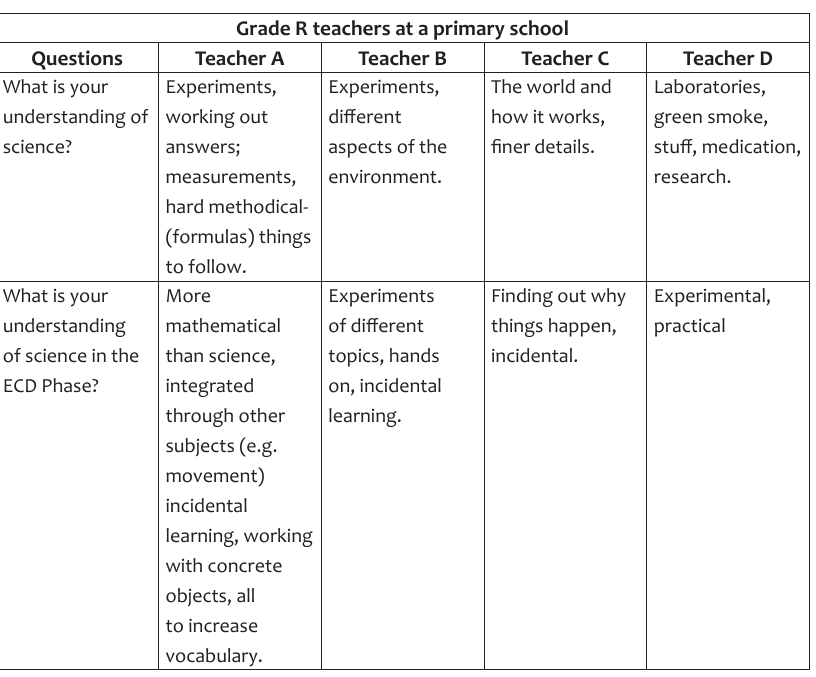
Table 6: Teachers responses (primary